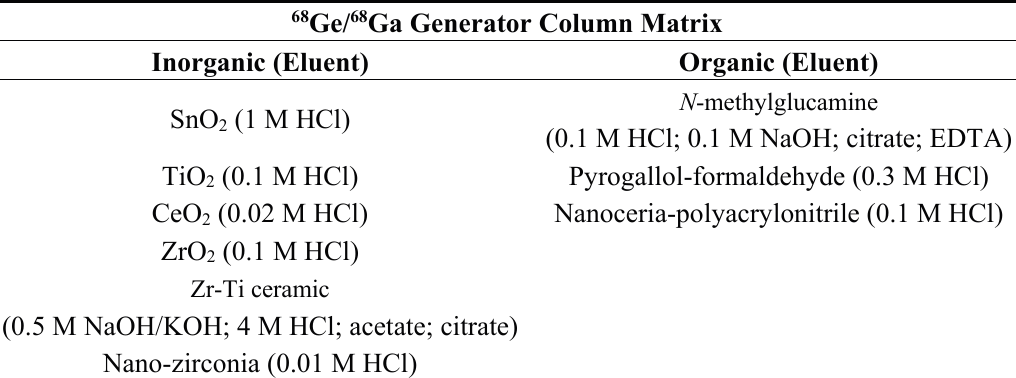
Table 1. Various sorbents and respective eluents used in column based 68 Ge/ 68 Ga generators. 68 Ge/ 68 Ga Generator Column